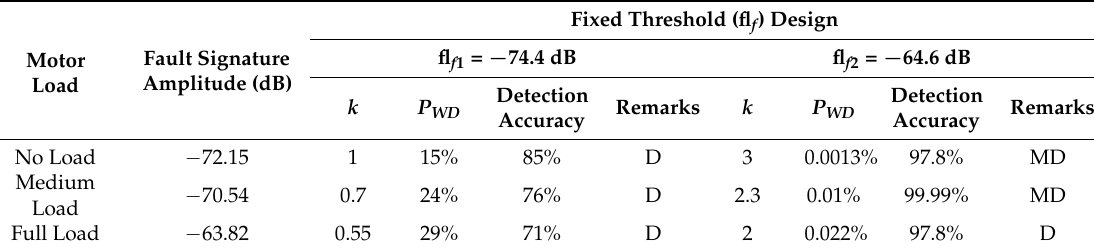
Table 4. Performance evaluation of fixed Threshold system.